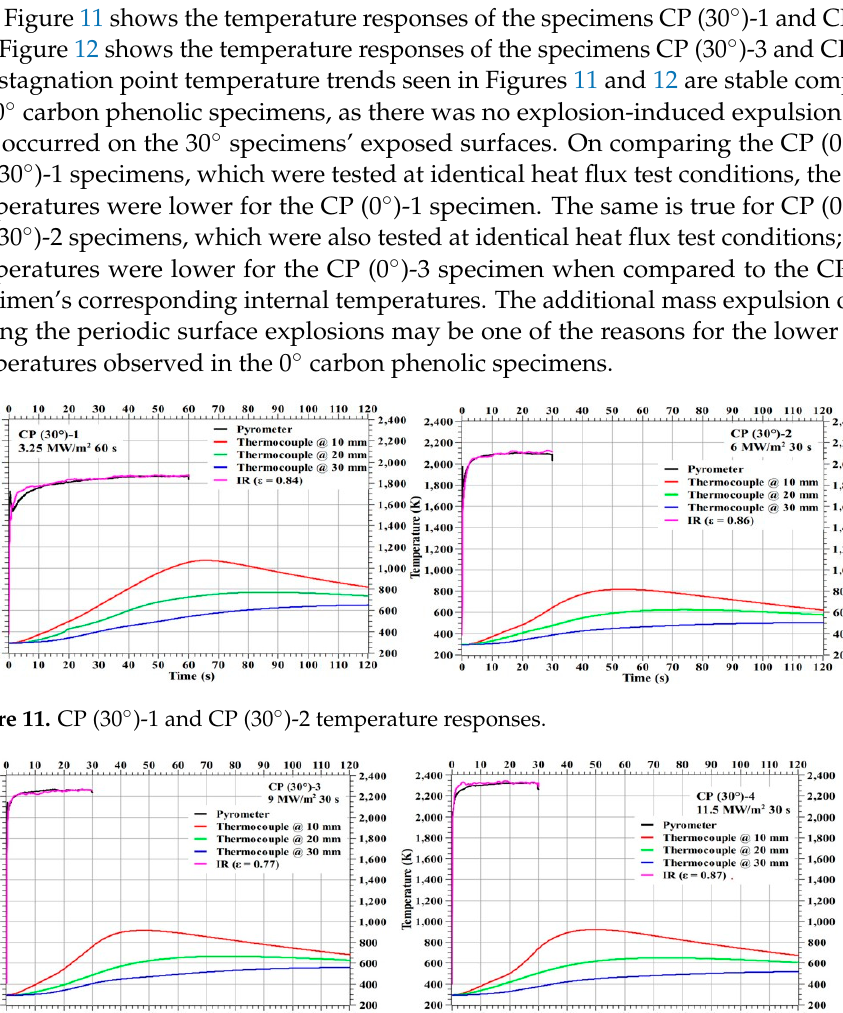
Figure 10. CP (0°)-1 (3.25 MW/m 2 , 60 s) and CP (0°)-3 (6 MW/m 2 , 30 s) exposed surface morphology changes.